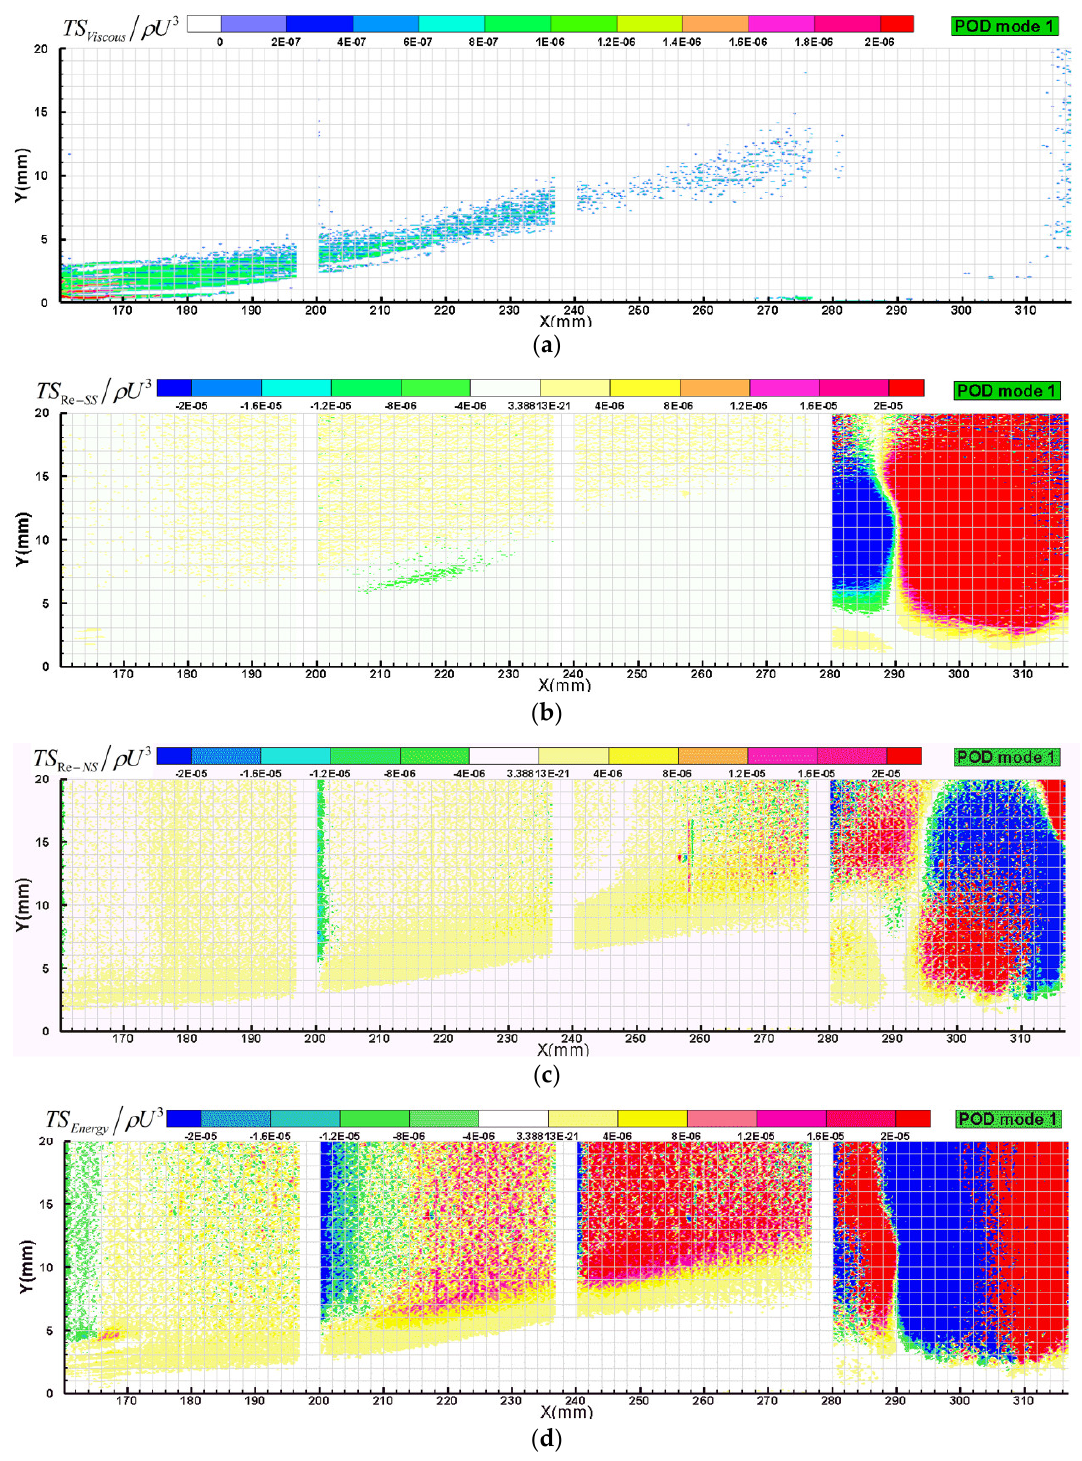
Figure 14. Entropy generation of first order mode: ( a ) the mean viscous dissipation term; ( b ) the Reynolds sheer stress term; ( c ) the Reynolds normal stress term; and ( d ) the energy flux term.